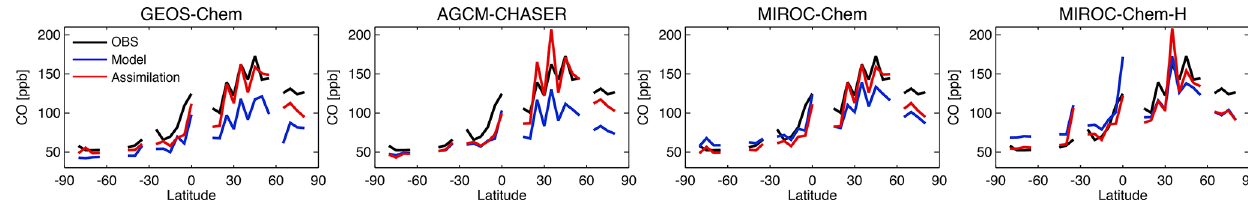
Figure 10. Latitudinal distributions of zonal mean surface CO concentrations (ppbv) averaged over the WDCGG surface measurement sites from the observations (black), control runs (blue), and data assimilation analyses (red).